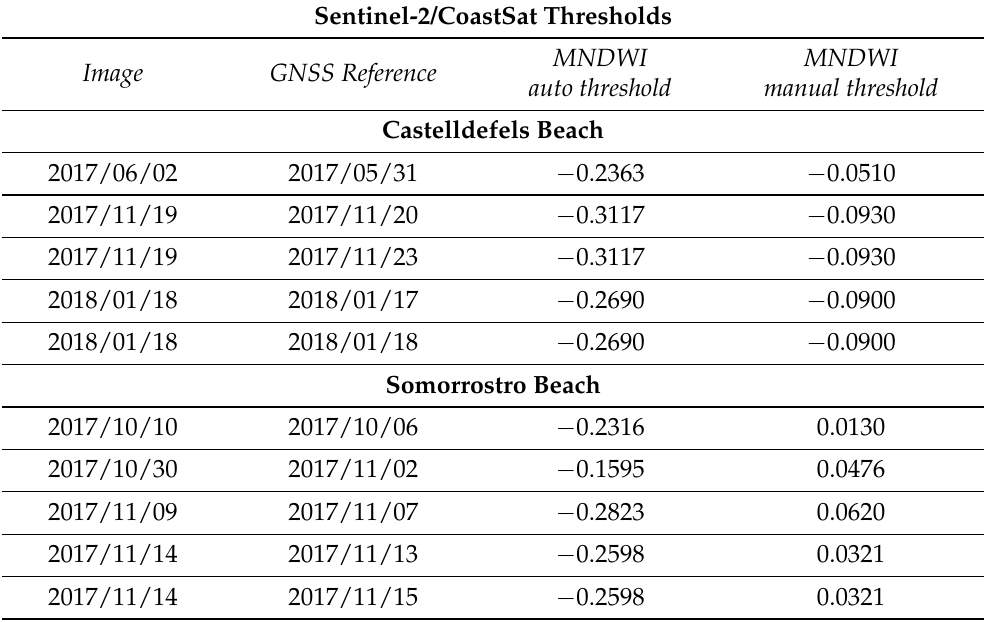
Table 2. MNDWI (Modified Normalized Difference Water Index) automatic and manual thresholds used to extract shorelines from CoastSat in Castelldefels and in Somorrostro beaches.